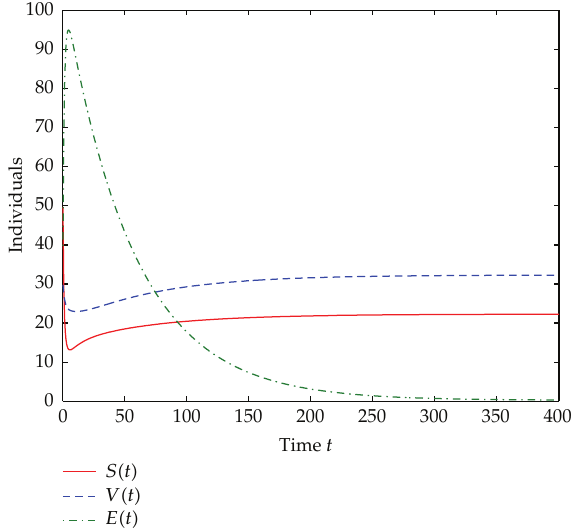
Figure 3: When R 0 (cid:8) 1, the disease-free equilibrium P 0 is globally asymptotically